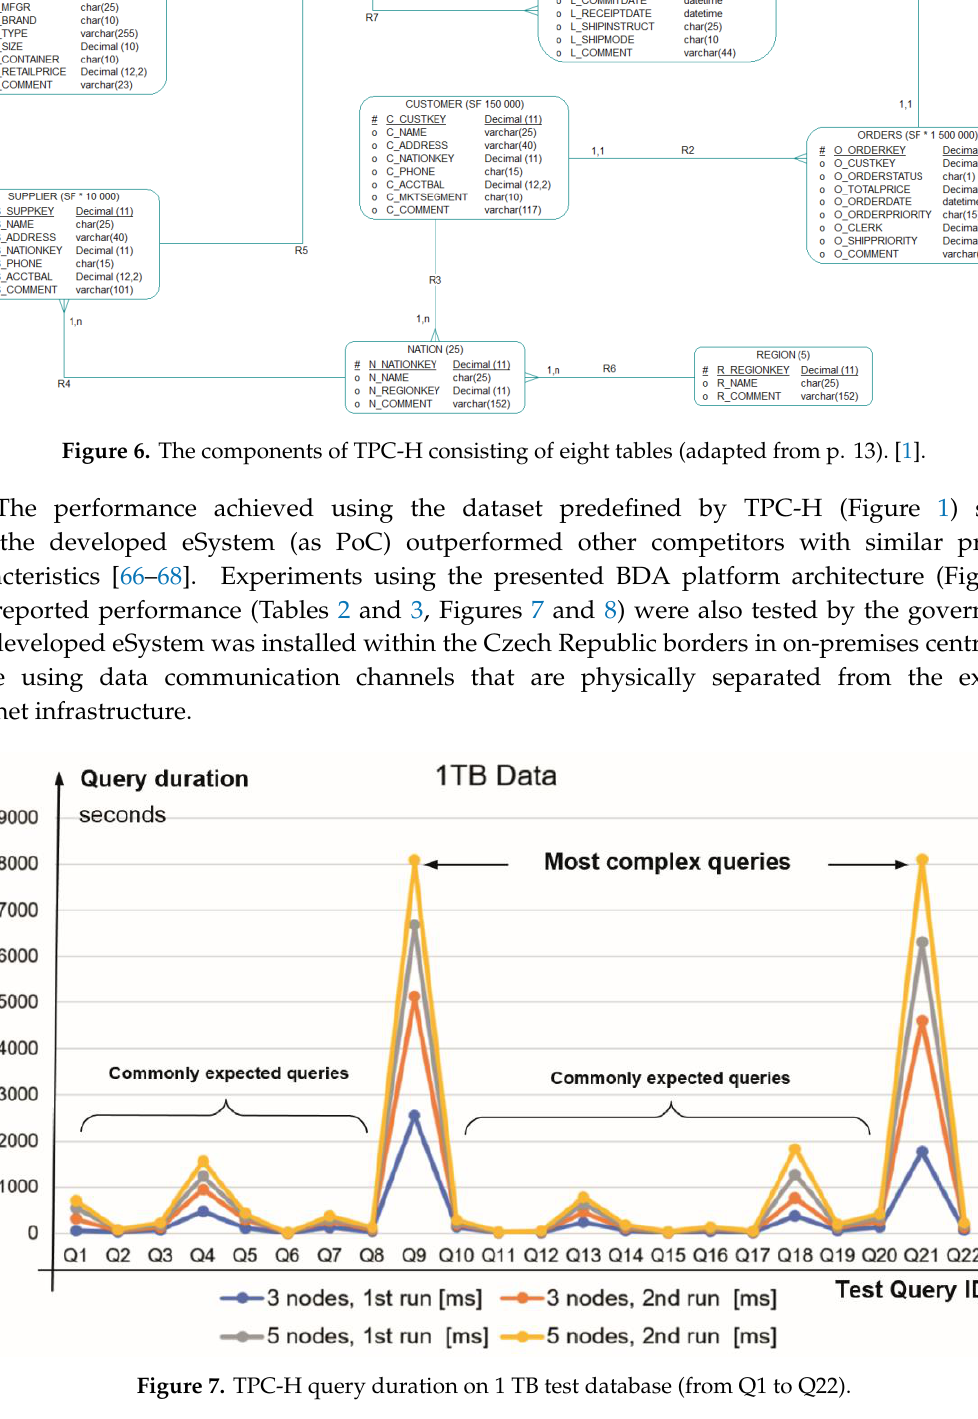
Figure 7. TPC-H query duration on 1 TB test database (from Q1 to Q22).